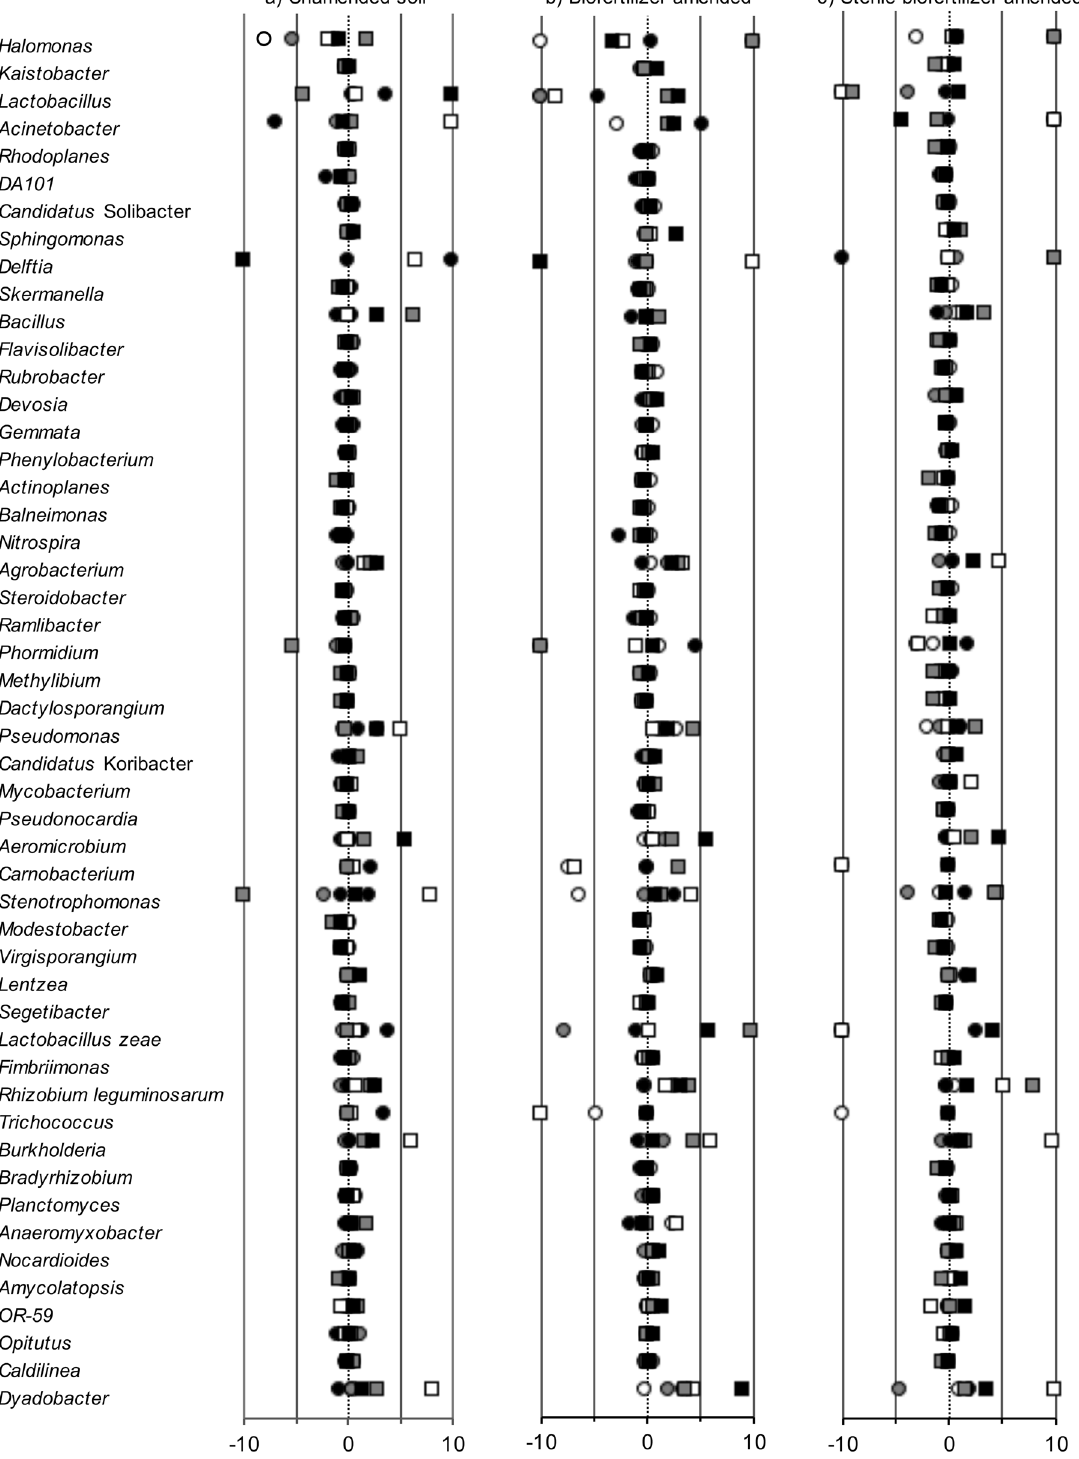
Figure 4. Ratio of the relative abundance of the 50 most abundant bacterial genera in the ( a ) unamended, ( b ) biofertilizer and ( c ) sterile biofertilizer amended non-rhizosphere soil after 44 days (white circle), 89 days (grey circle) and 130 days (black circle) or the rhizosphere soil after 44 days (white square), 89 days versus the uncultivated